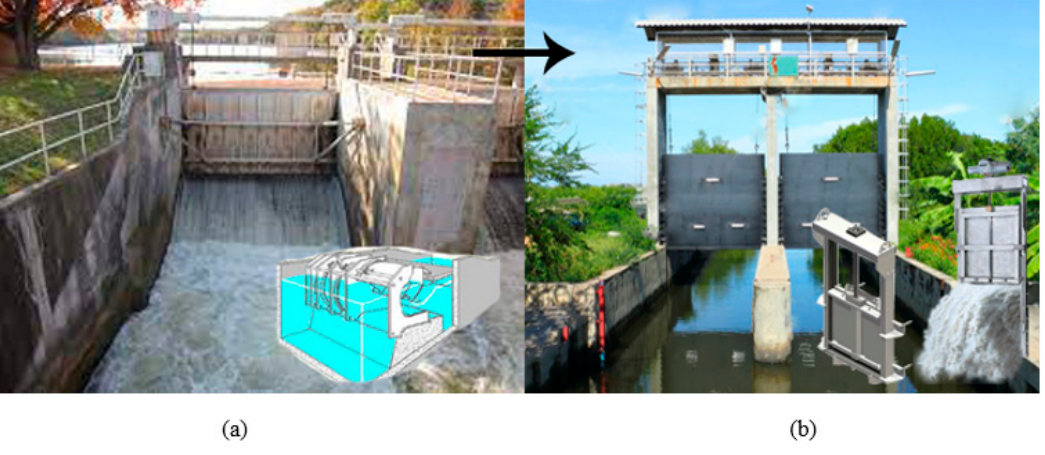
Figure 2. ( a ) Neyrpic module reservoir, ( b ) Sliding valve.